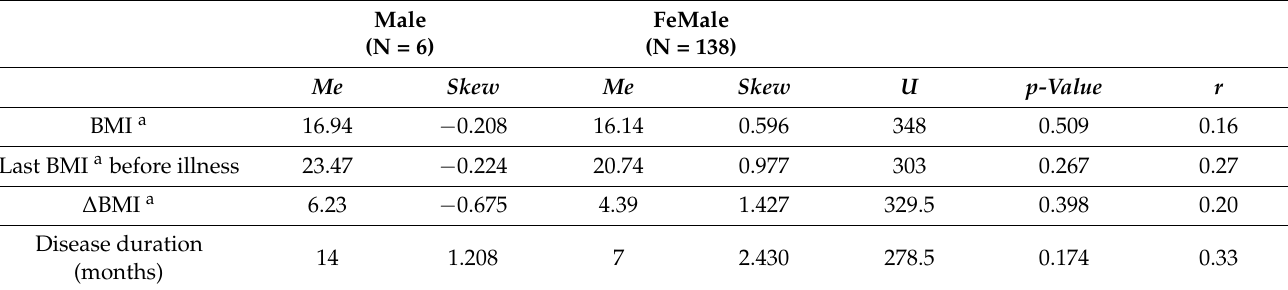
Table 3. Clinical features of Middle adolescence Participants at admission.